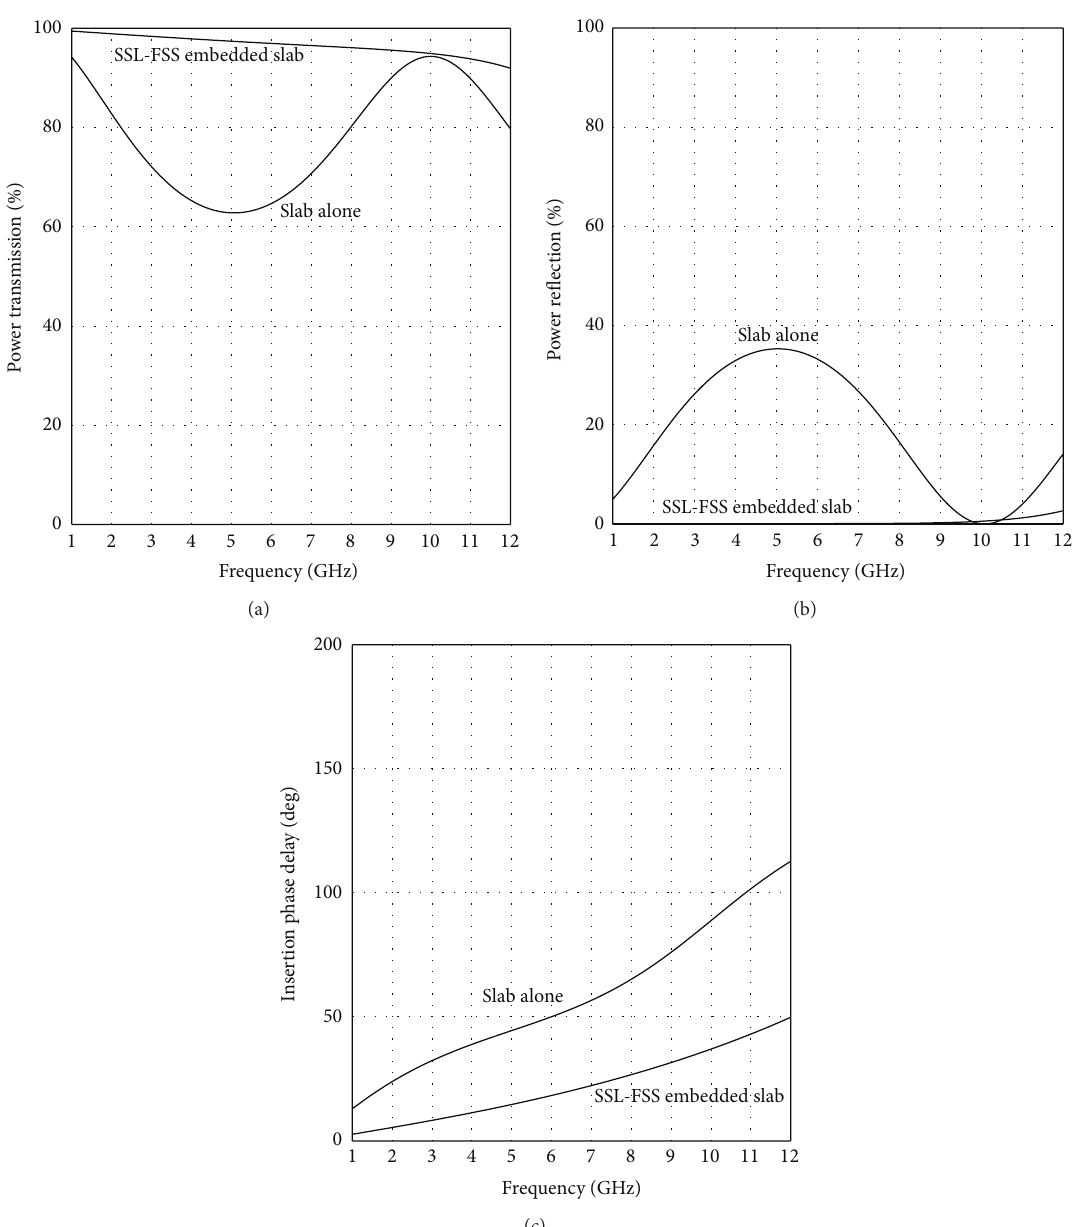
Figure 3: (a) SSL-FSS embedded monolithic half-wave slab design results in higher power transmission characteristics at normal incidence over a broadband (1GHz–12 GHz) as compared to the slab alone case. (b) SSL-FSS embedded monolithic half-wave slab design results in lower power reflection characteristics at normal incidence over a broadband (1GHz–12 GHz) as compared to the slab alone case. (c) SSL-FSS embedded monolithic half-wave slab design results in superior insertion phase delay characteristics at normal incidence over a broadband (1GHz–12 GHz) as compared to the slab alone